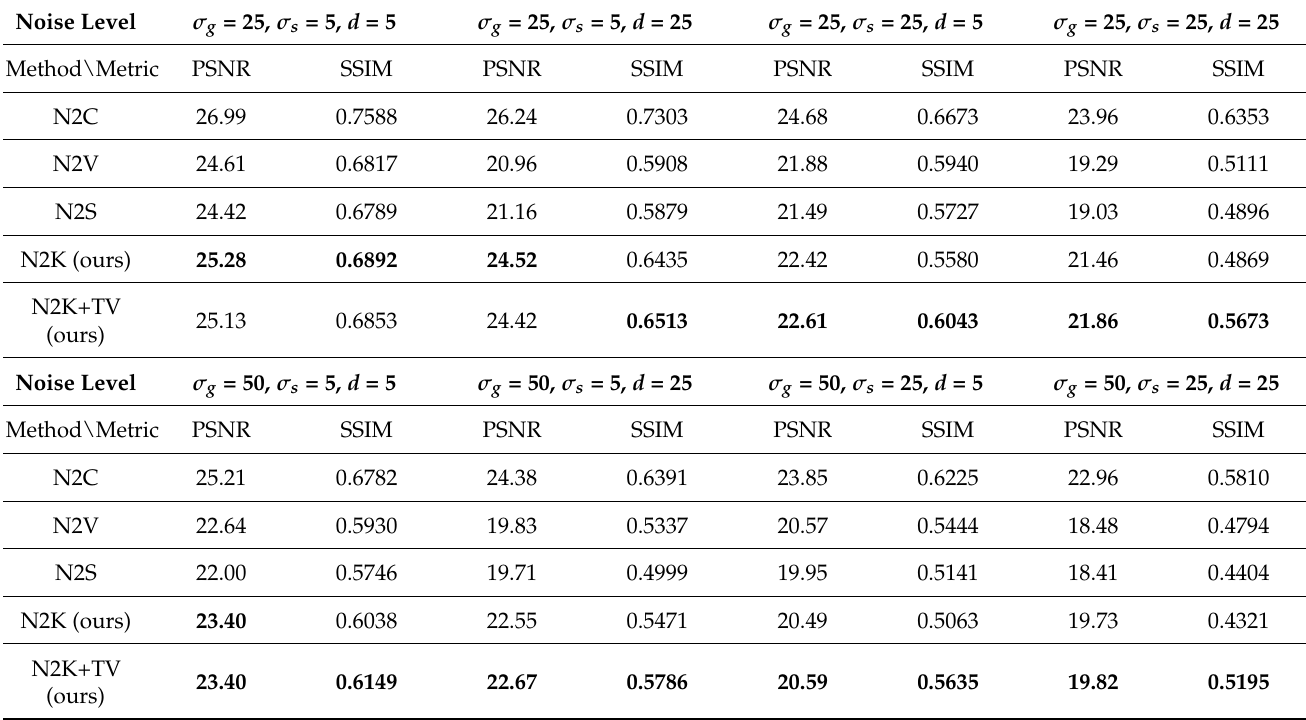
Table 1. Performance of baselines, the proposed method and the proposed method+TV on the BSD68 test set. Boldface denotes the best among all except